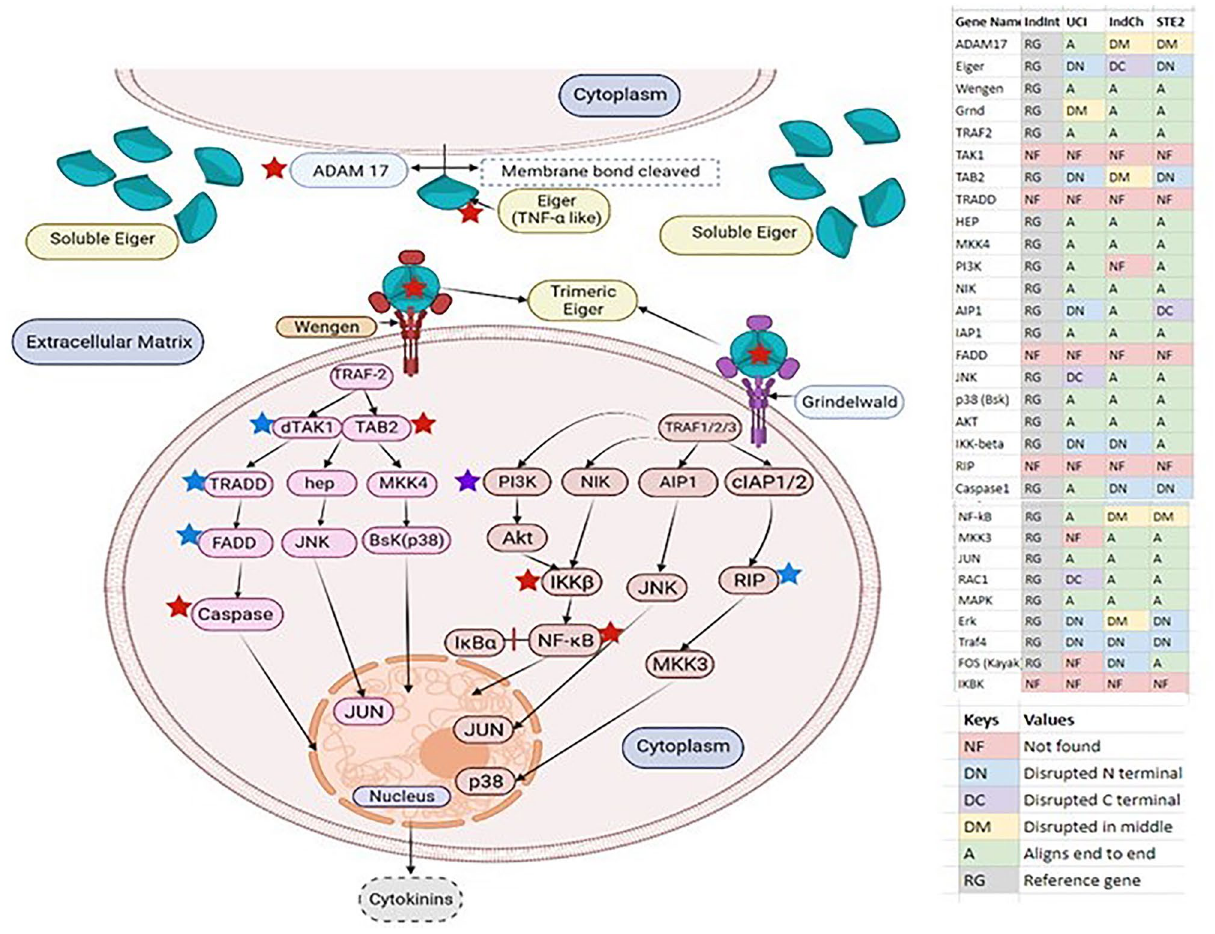
Figure 4. Pathways leading to Eiger-Grnd/Wgn-mediated signaling collated from TNF-TNFR and Eiger-Wgn- mediated signaling pathways obtained from the KEGG database 43–45 and validated using other sources 46,47 .